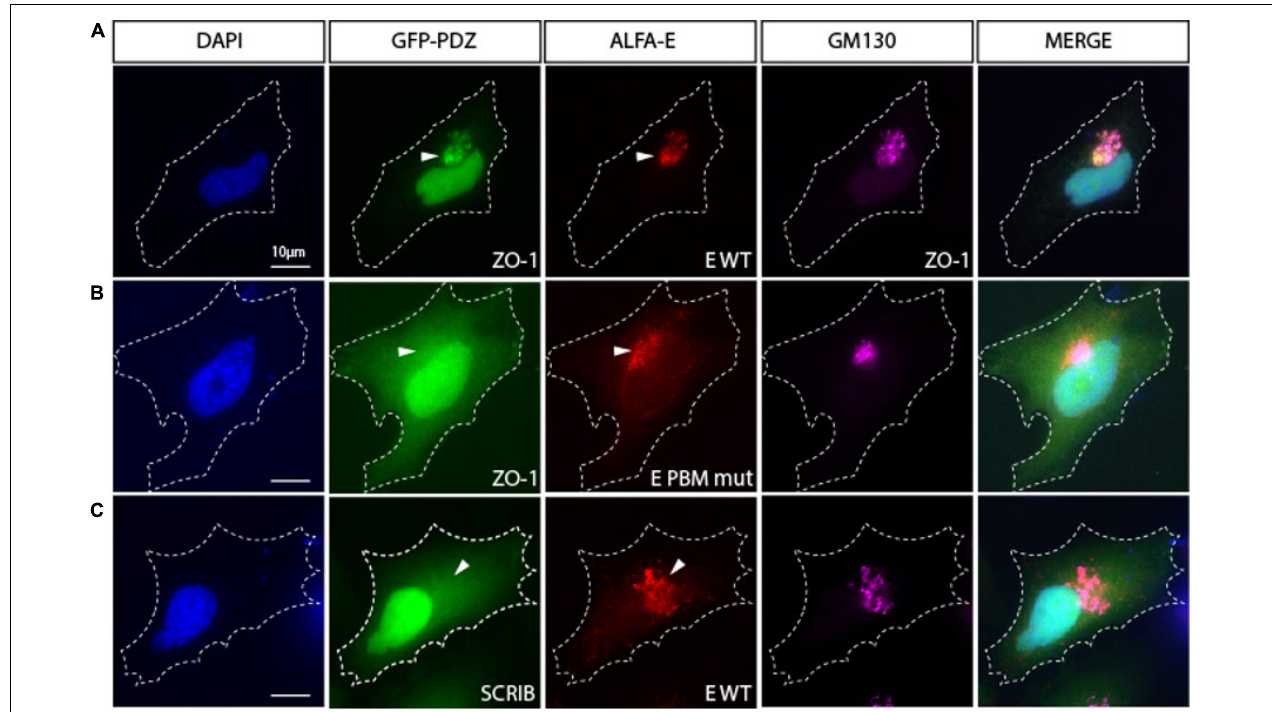
FIGURE 4 | The viral E protein recruits the PDZ domain of ZO1 to the Golgi apparatus. (A) Hela cell cotransfected with encoding constructs GFP-PDZ2 of ZO1 and ALFA-E (red) displays Golgi recruitment of both proteins as indicated by GM130 staining (Magenta). (B) Cotransfection of GFP-ZO1 with ALFA-E PBM mutant (red) does not lead to the recruitment of GFP-ZO1 to the Golgi apparatus. (C) Hela cell cotransfected with GFP-PDZ1 of SCRIB and ALFA-E (red) does not show recruitment of the proteins to the Golgi apparatus (Magenta). White arrowheads indicate Golgi apparatus position. Nuclei are stained with DAPI. Bars correspond to 10 µ m.